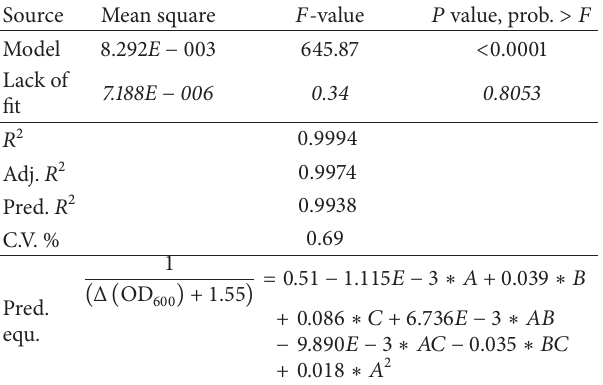
Table 4: Summary of ANOVA for the bacterial growth model fit.